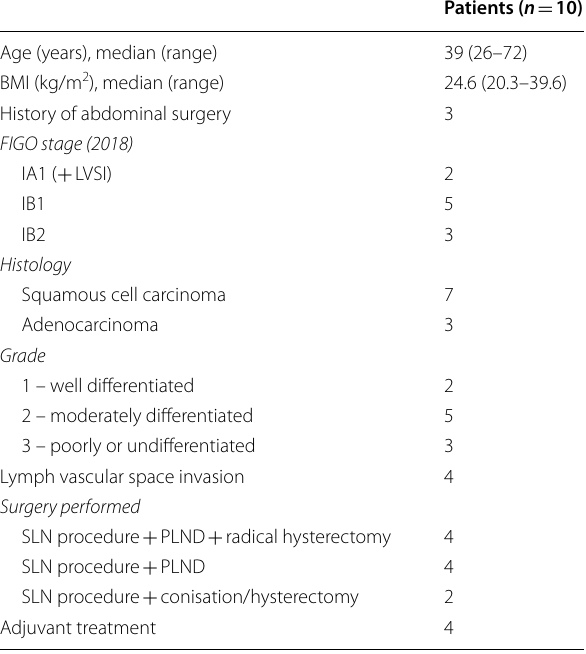
BMI —body mass index; FIGO —International Federation of Gynecology and Obstetrics; LVSI —lymph vascular space invasion; SLN —sentinel lymph node; PLND —pelvic lymph node